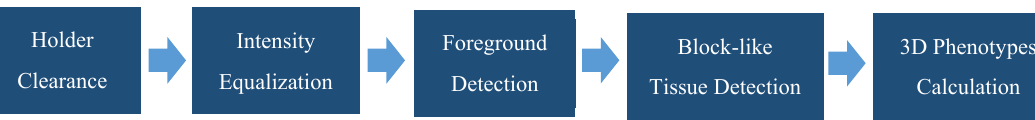
Figure 4. The pipeline of pro-processing of CT image. The parts are all automated.